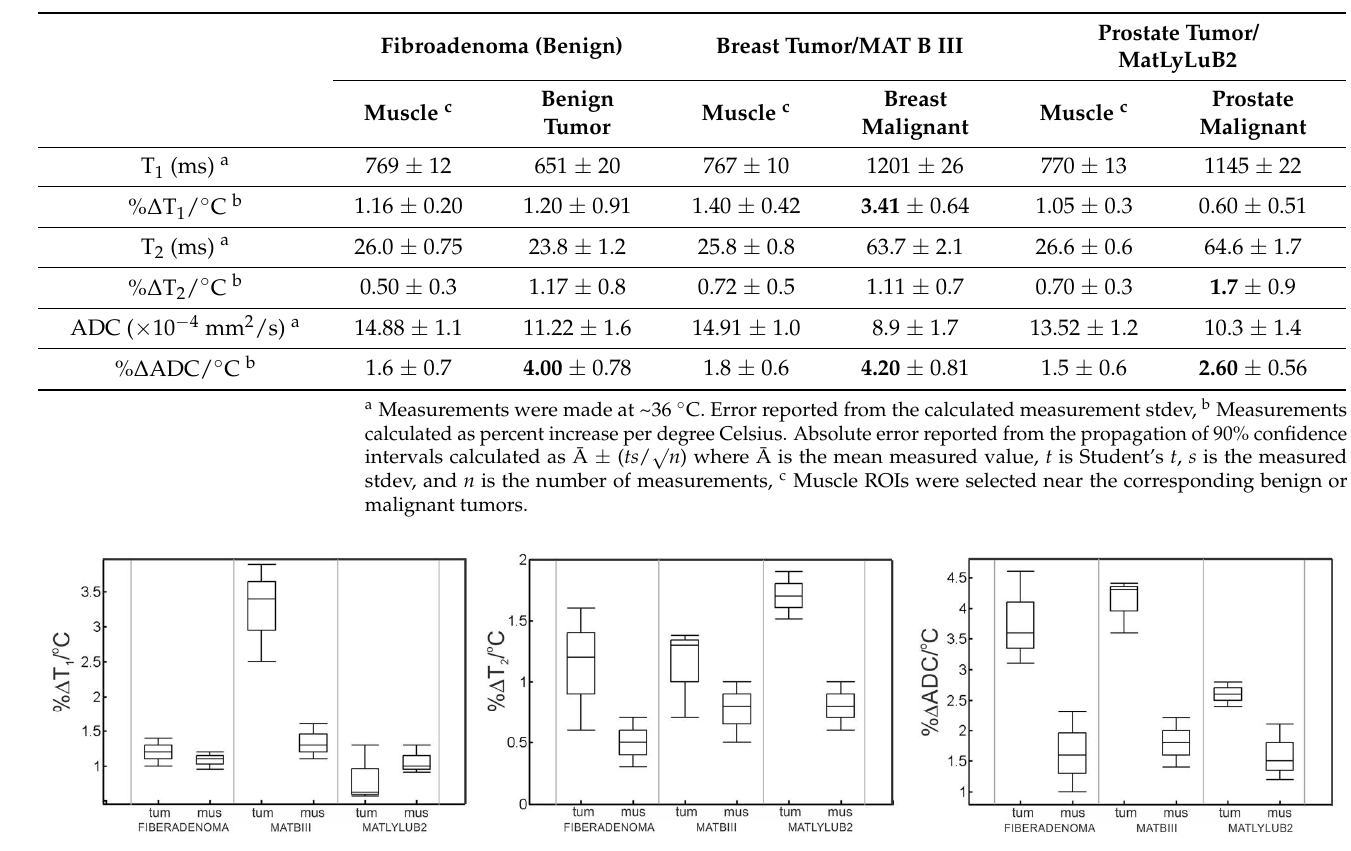
Figure 4. ( a ) Reference axial images of the same rat (top and bottom) with MAT B III tumor. Top images in ( b – d ) are quantitative T 1 , T 2 , and ADC maps, respectively, at 26 °C. Bottom images in ( b – d ) are quantitative T 1 , T 2 , and ADC maps, respectively, at 36 °C. General locations of the tumor and muscle regions are indicated on the images. Table 1. Summary of (i) quantitative quantities a and (ii) thermally-induced changes in quantitative quantities b . Bolded quantities indicate t-test p -value < 0.05 for comparisons indicated in text.